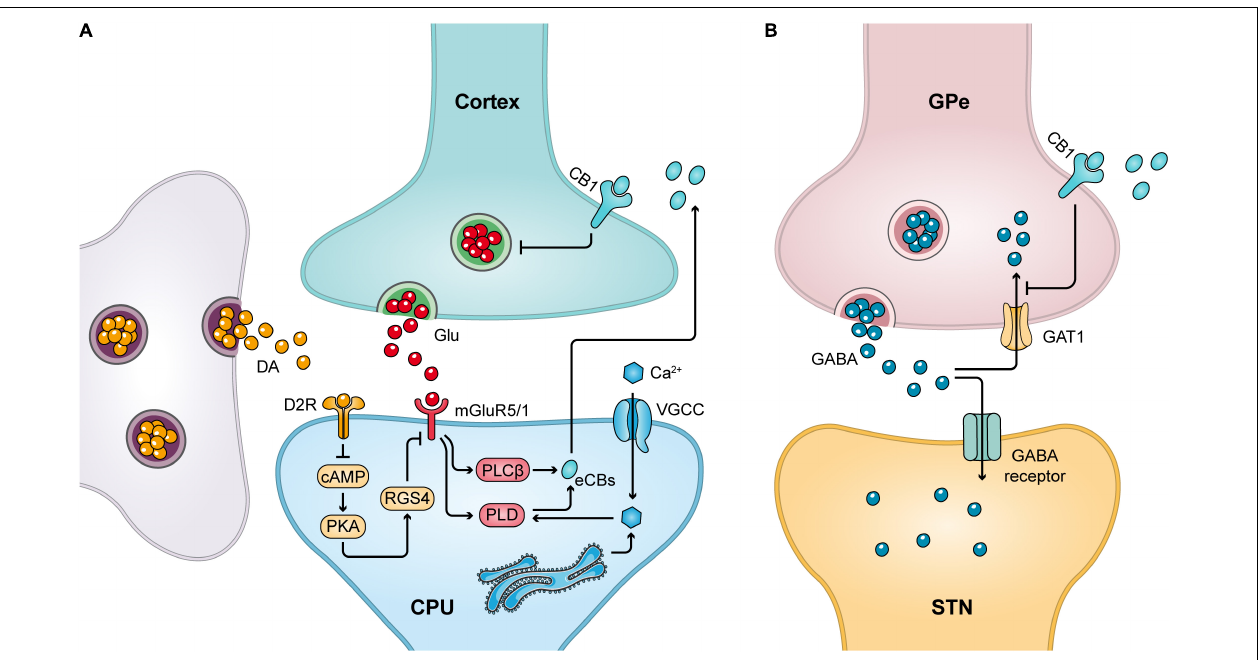
FIGURE 2 | CB1 receptor-mediated retrograde signaling mechanism. (A) Release of Glu from the cortical striatal glutamatergic neurons can stimulate the release of eCBs from postsynaptic neurons, which in turn acts on CB1 receptors in the presynaptic membrane to inhibit presynaptic Glu release. Meanwhile, dopaminergic neurons can promote cannabinoid production by decreasing postsynaptic RGS4 phosphorylation levels. (B) Stimulation of the presynaptic CB1 receptor in GPe inhibits the reuptake of GABA by GABA transporter protein 1 (GAT1), thereby increasing local GABA